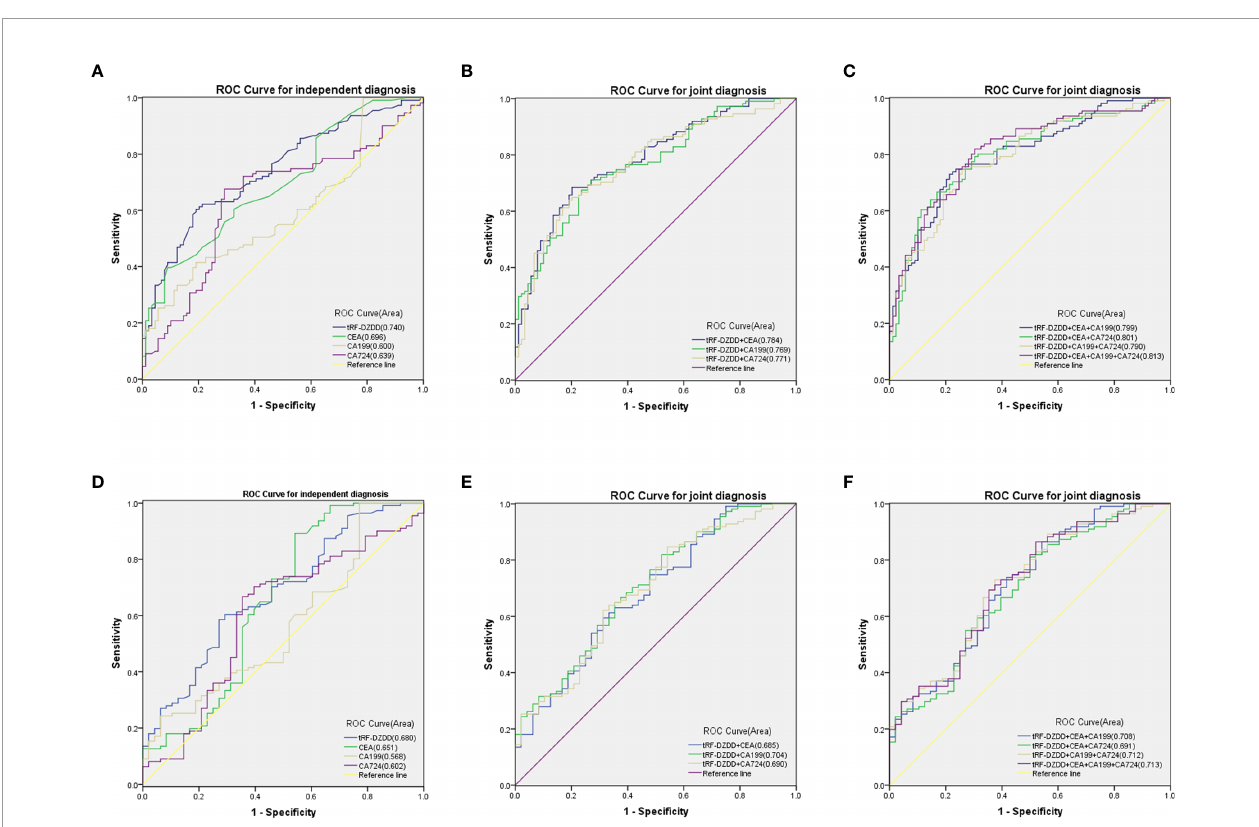
FIGURE 5 | Evaluation of the diagnostic accuracy of serum tRF-31-U5YKFN8DYDZDD and combined diagnostic model in GC. (A – C) ROC curves for GC diagnosis using serum tRF-31-U5YKFN8DYDZDD, CEA, CA199, and CA724 between GC patients and healthy controls. (D – F) ROC curves for GC diagnosis using serum tRF- 31-U5YKFN8DYDZDD, CEA, CA199, and CA724 between GC and gastritis patients. (B, C, E, F) Combined diagnostic ef fi cacy of serum tRF-31-U5YKFN8DYDZDD, CEA, CA199, and CA724 exerted the best diagnostic ef fi cacy in distinguishing GC patients and non-malignant